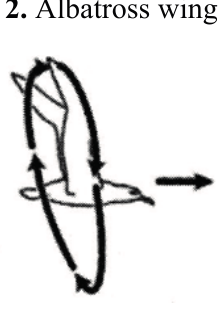
Figure 2. Albatross wing model.